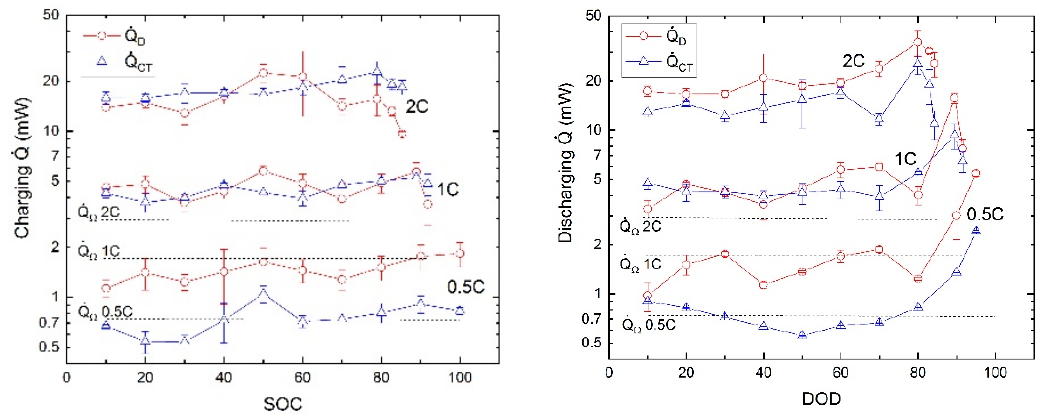
Figure 4. Irreversible heat flow rates due to ohmic, charge transfer, and diffusion impedances during charge and discharge versus SOC ( left ) and depth of discharge (DOD) ( right ).